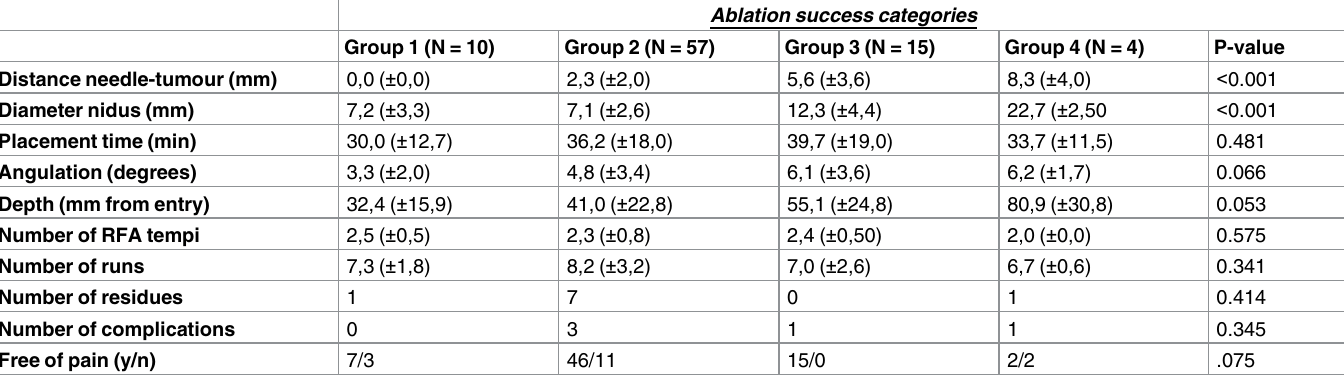
Table 4. Population separated in groups on procedure accuracyand